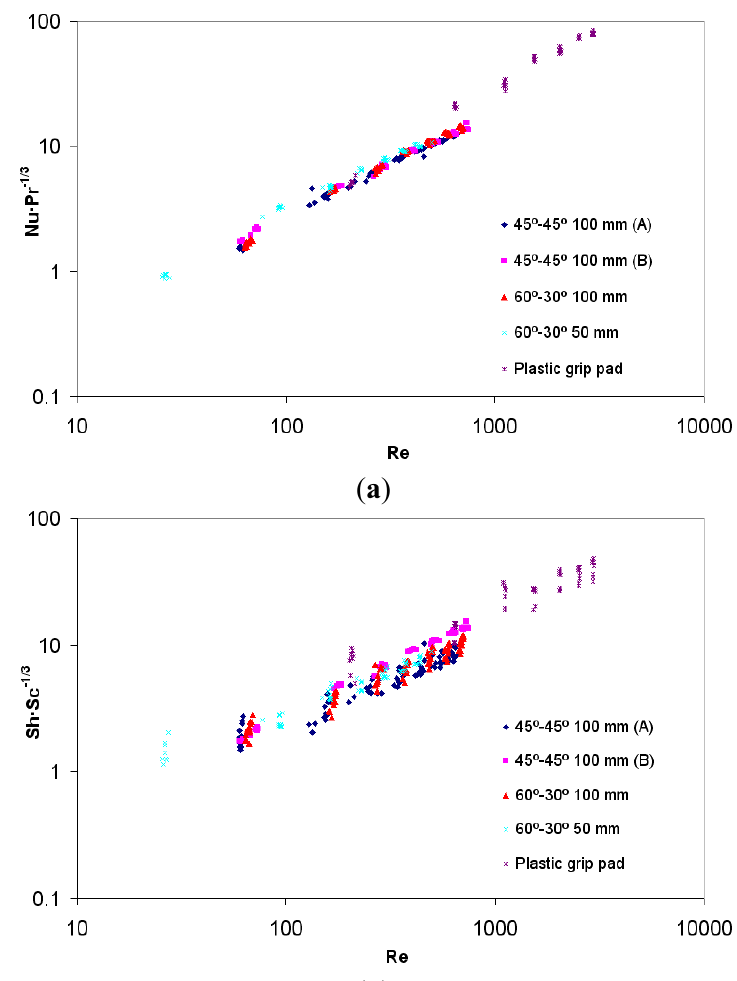
Figure 10. Uncalibrated non-dimensional correlations of ( a ) heat transfer coefficients and ( b ) mass transfer coefficients of all tested